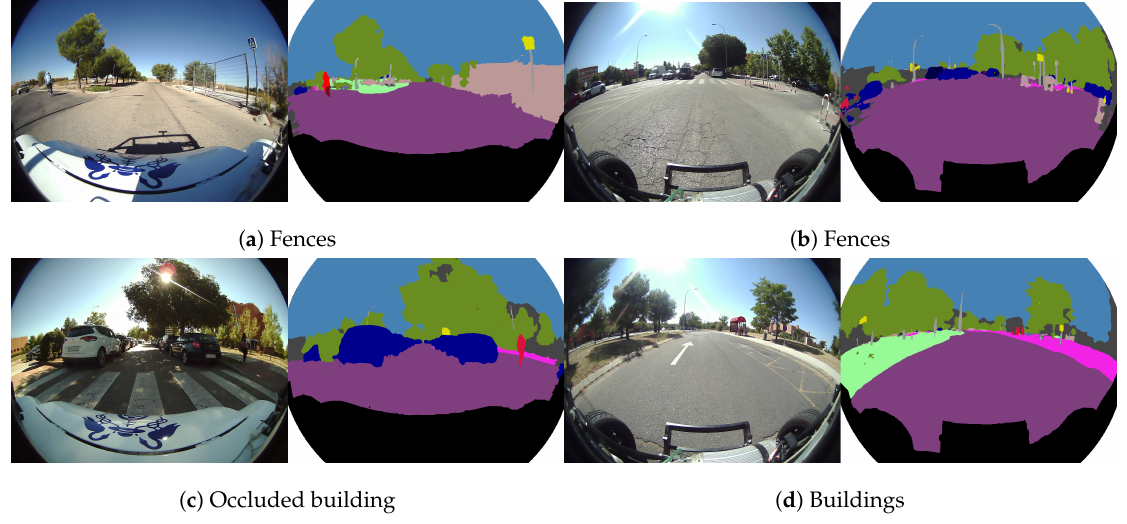
Figure 16. Real fisheye camera semantic segmentation examples for the construction